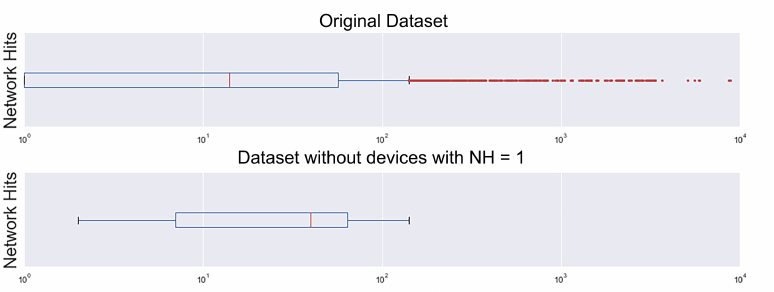
Figure 11. Outcome of filtering the data from devices with just one NH. Dataset: Val: 18/01/01, log scale.